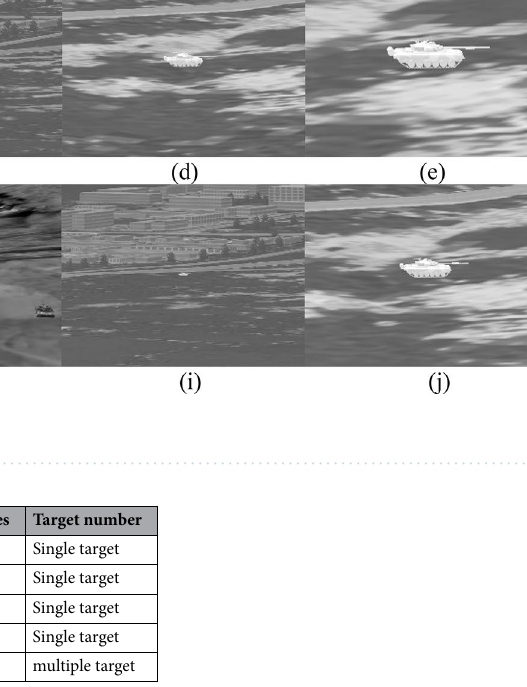
Table 2. Types of ground background and image data contained in infrared tank target data set.